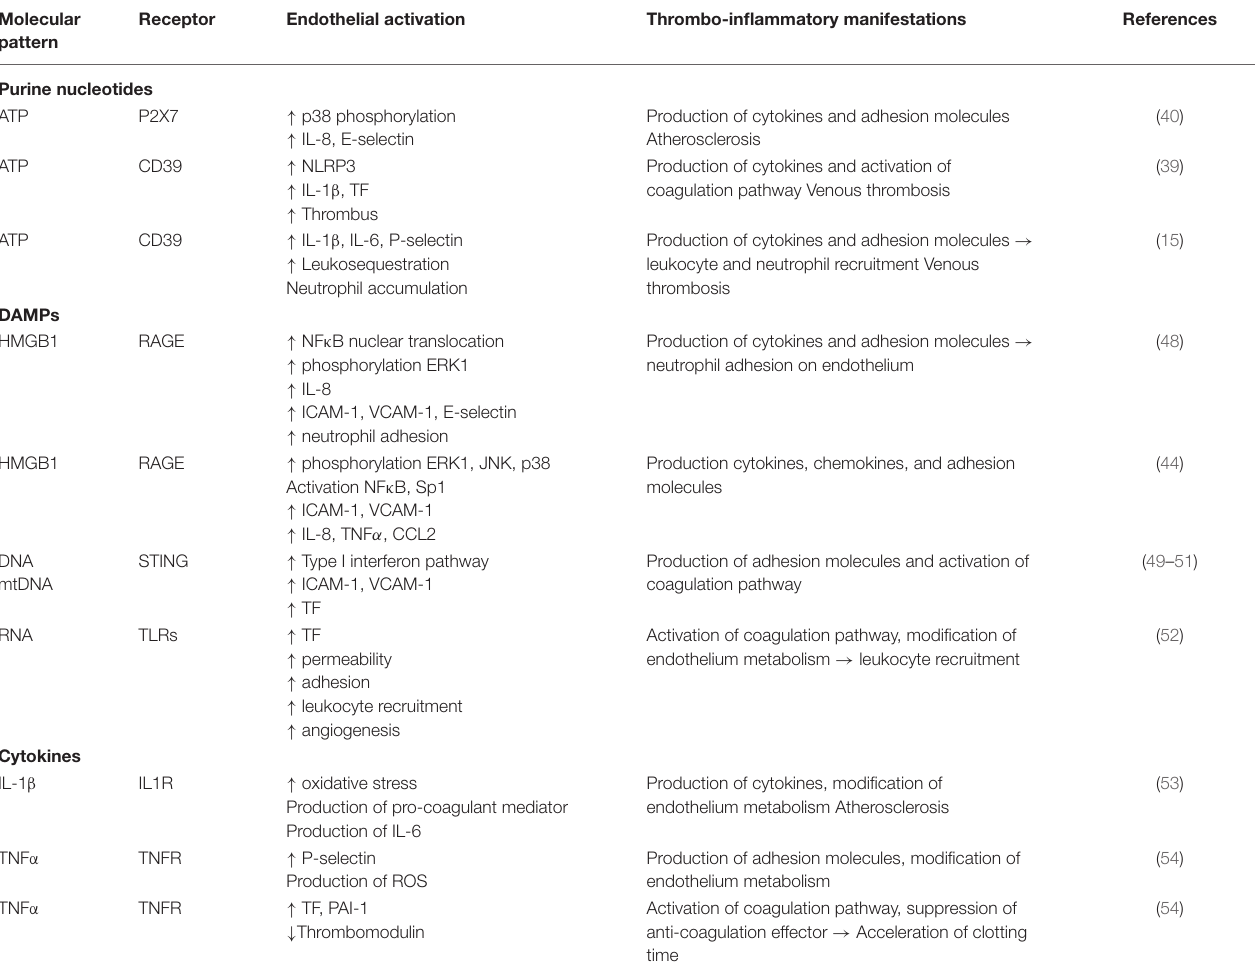
TABLE 1 | Endothelial responses to molecules from the microenvironment and thrombo-inflammatory consequences. Molecular